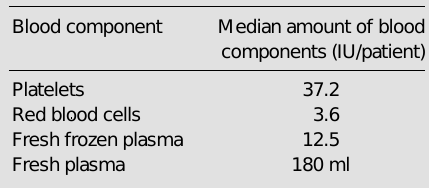
Table 2 - Utilization of blood components in ATRA